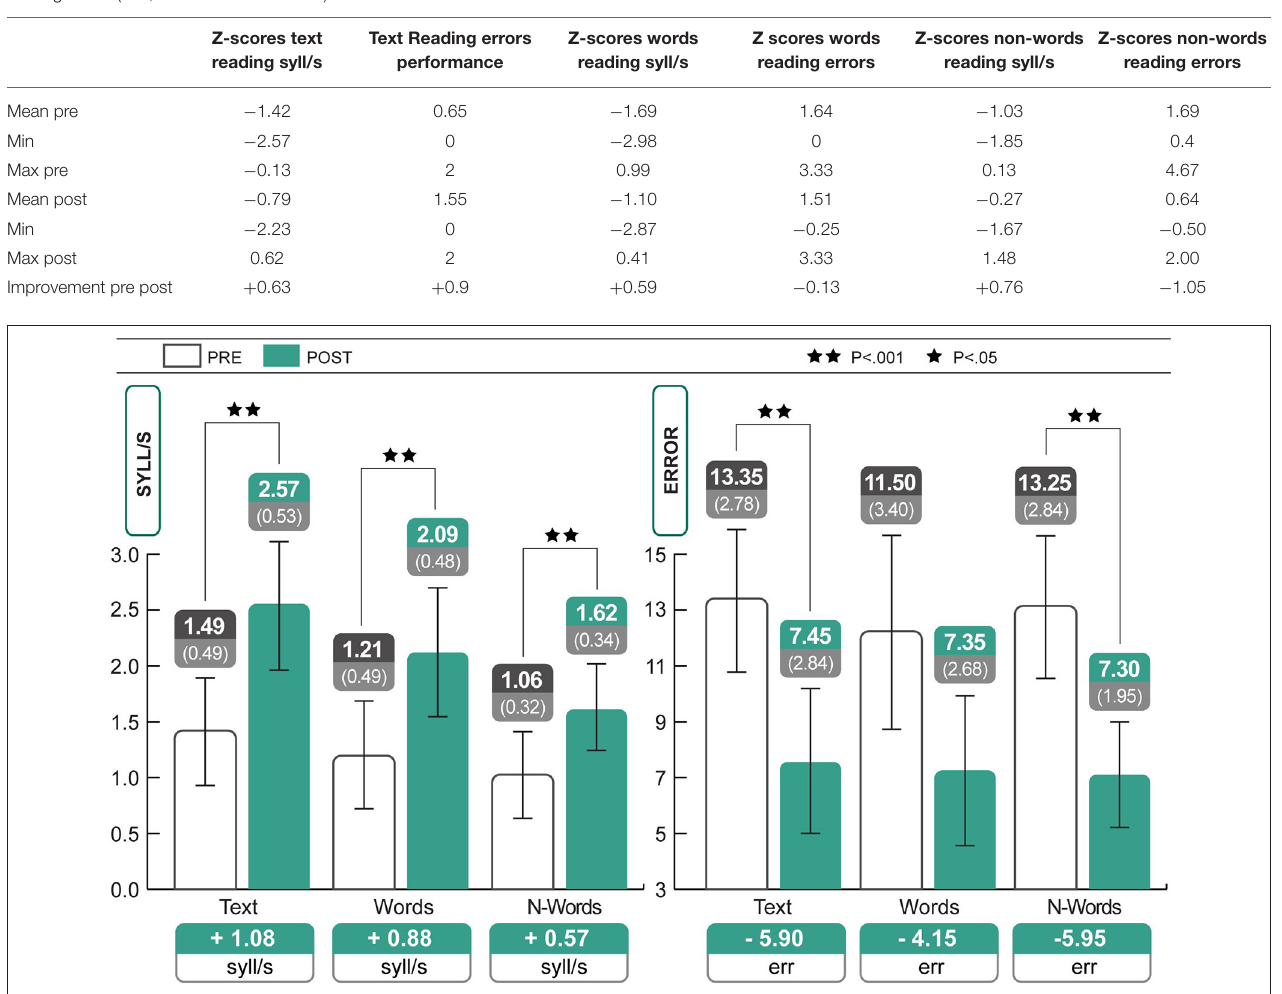
TABLE 2 | Exp 1: Average, minimum value (Min) and maximum value (Max) calculated on Z-scores; errors and syllables per second (syll/s) calculated on Z-scores of readings tests (text, words and